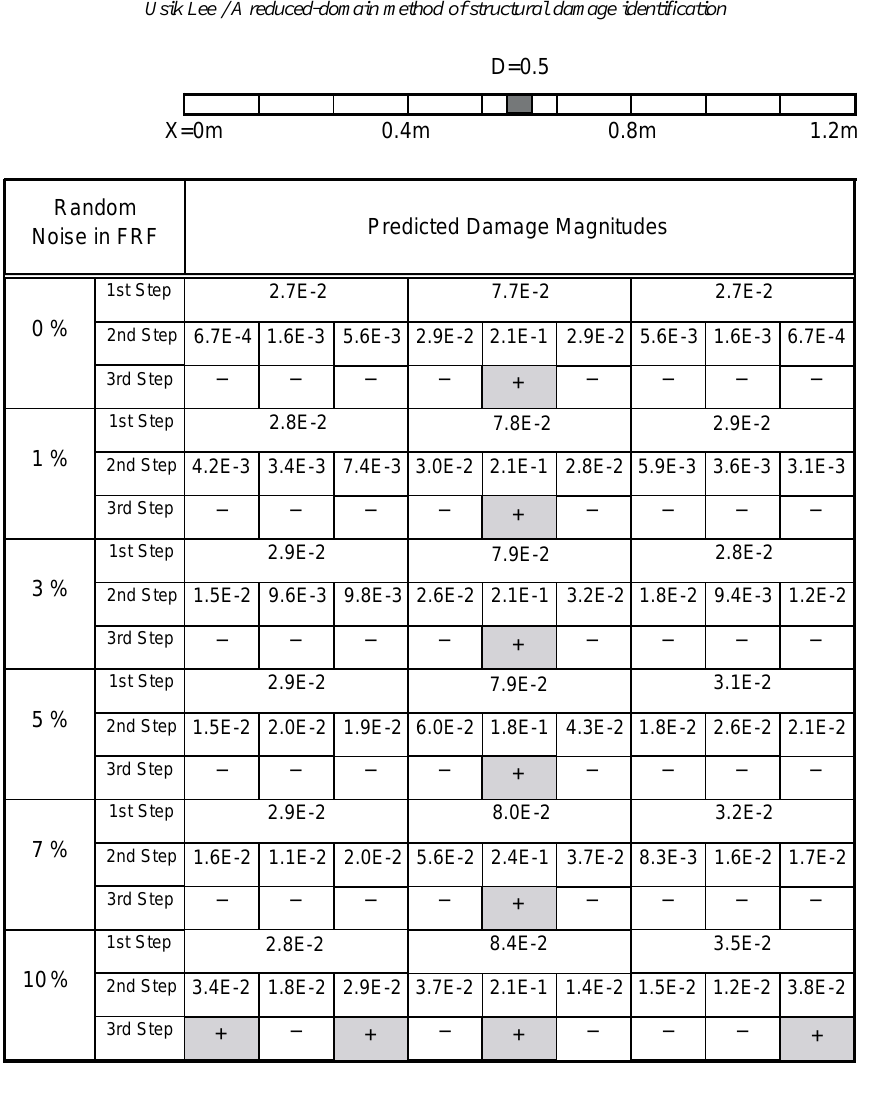
Fig. 2. Numerical validation of the three-steps process with varying the level of the noise in measured FRF-data. Equation (19) implies that, by removing